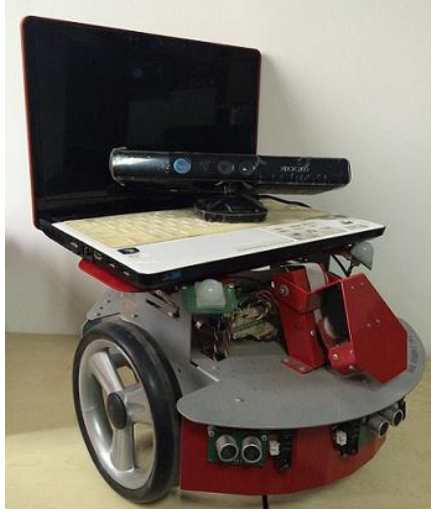
Figure 13. RGB-D SLAM system architecture based on Dr Robot